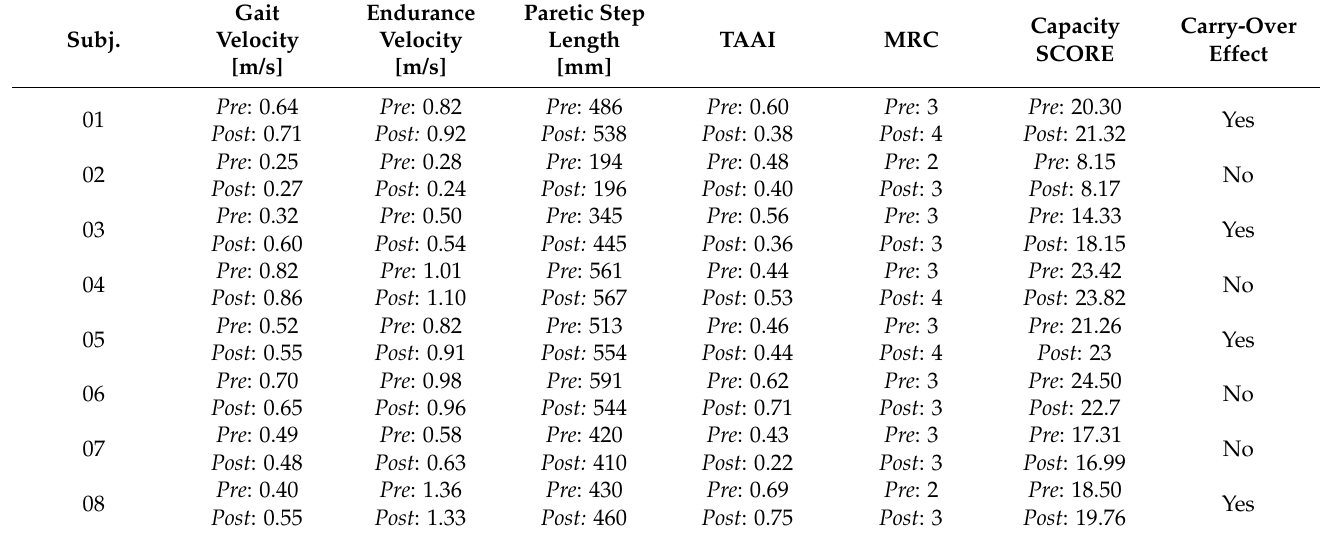
Table 2. Patients’ pre-post clinical scores and carry-over evaluation. TAAI: Tibialis Anterior Activation Index; MRC: Medical Research Council index. Gait Subj.